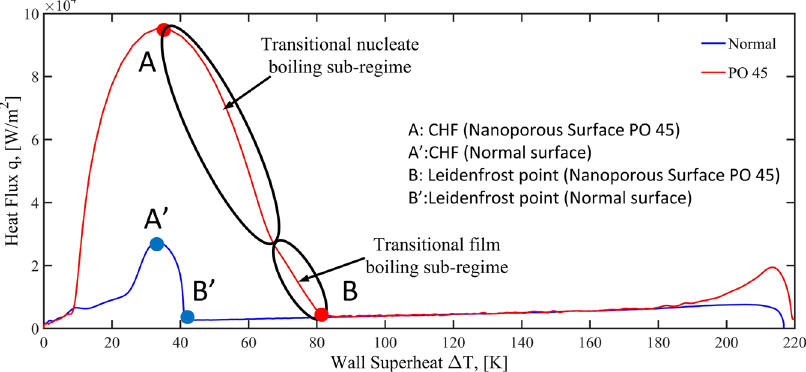
Figure 10. Comparison of the heat fluxes for nanoporous and conventional surfaces during